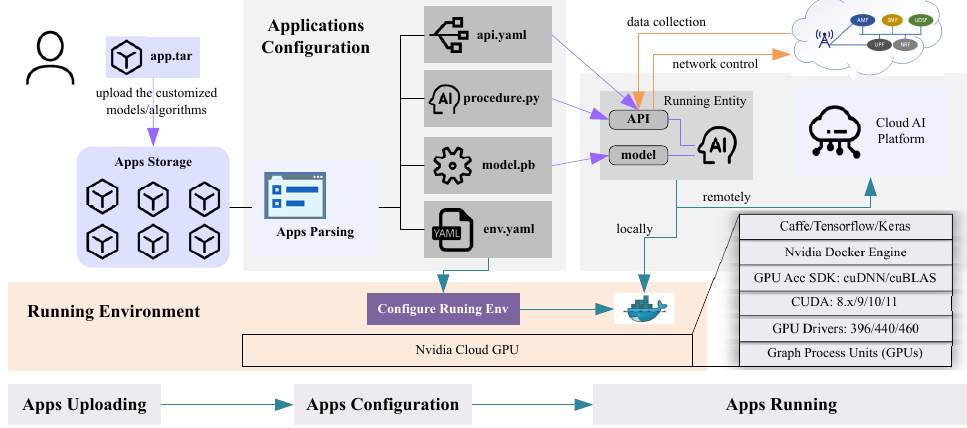
Figure 3. The procedure for uploading and running customized AI